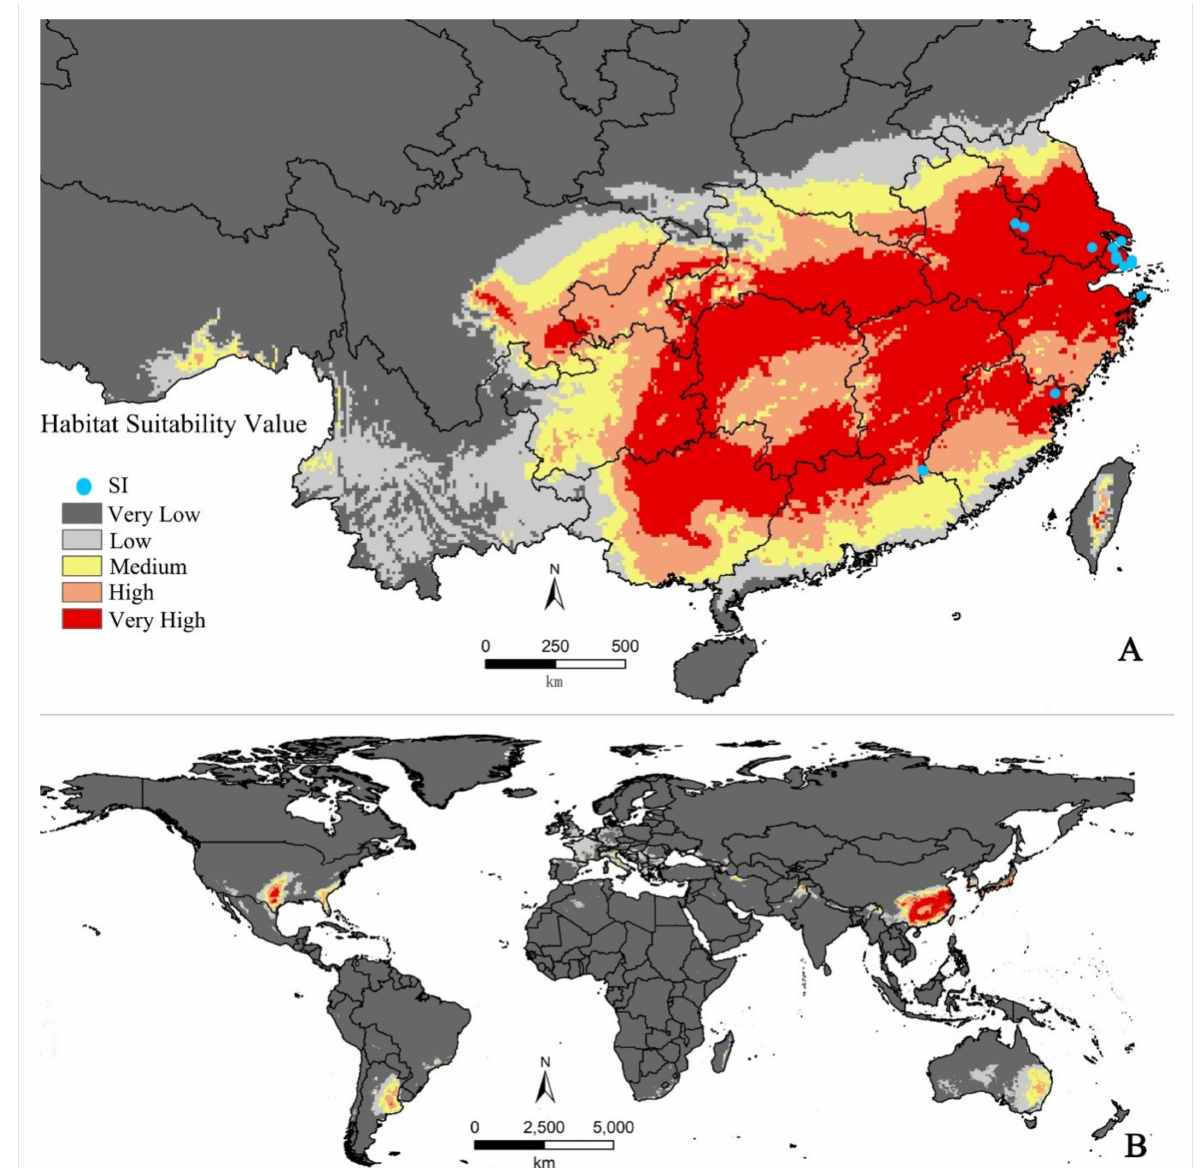
Figure 2. Potential geographical distribution of SI by MaxEnt; ( A ) potential distribution in China; ( B ) potential world distribution. SI: sweetgum